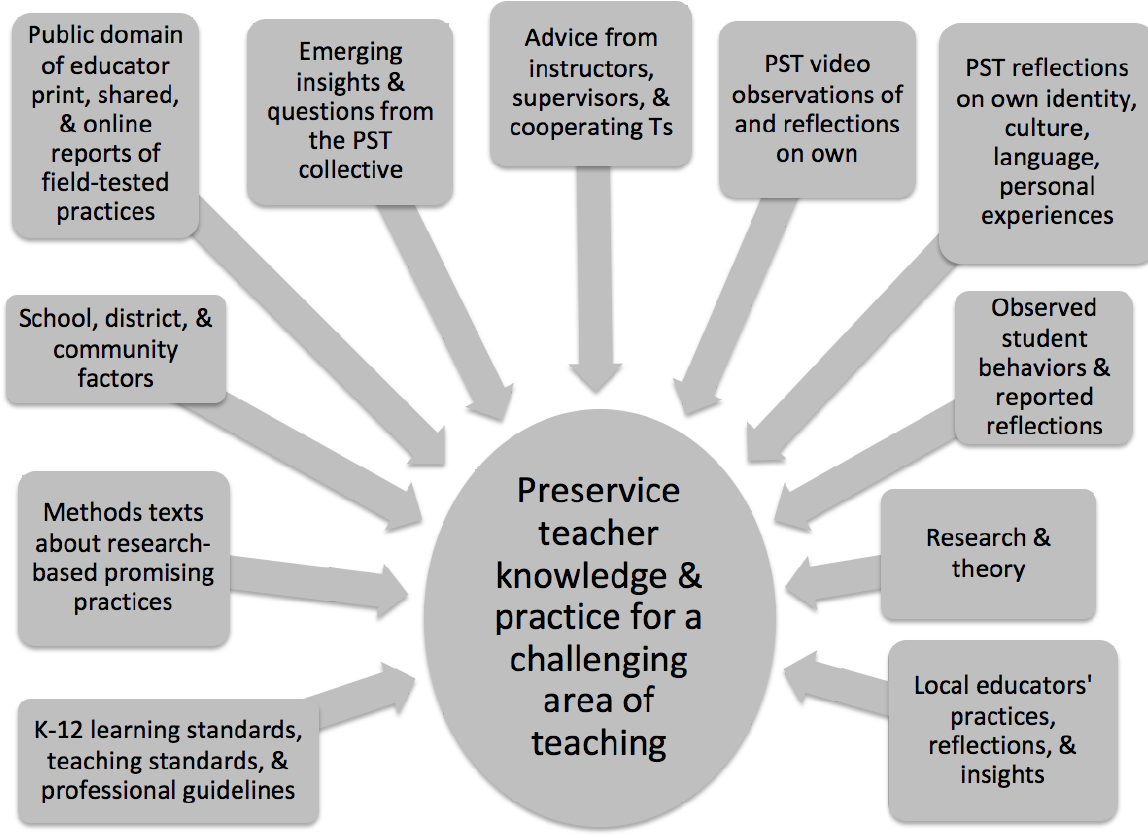
Figure 1: A Democracy of Resources that May Inform and Guide Development of Knowledge and Practice of Preservice